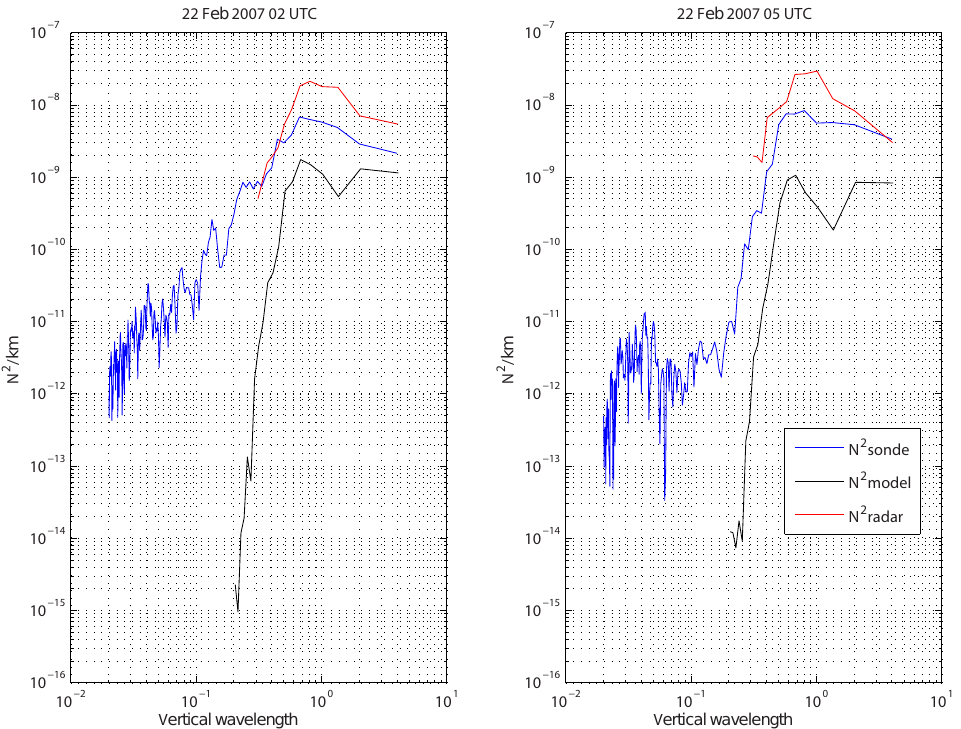
Figure 7. Spectrum of fluctuations of N 2 in vertical profiles from 10 to 14km height, from ESRAD, the WRF model and radiosondes, for the times of two radiosondes, 02:00 and 05:00UTC on 22 February 2007.